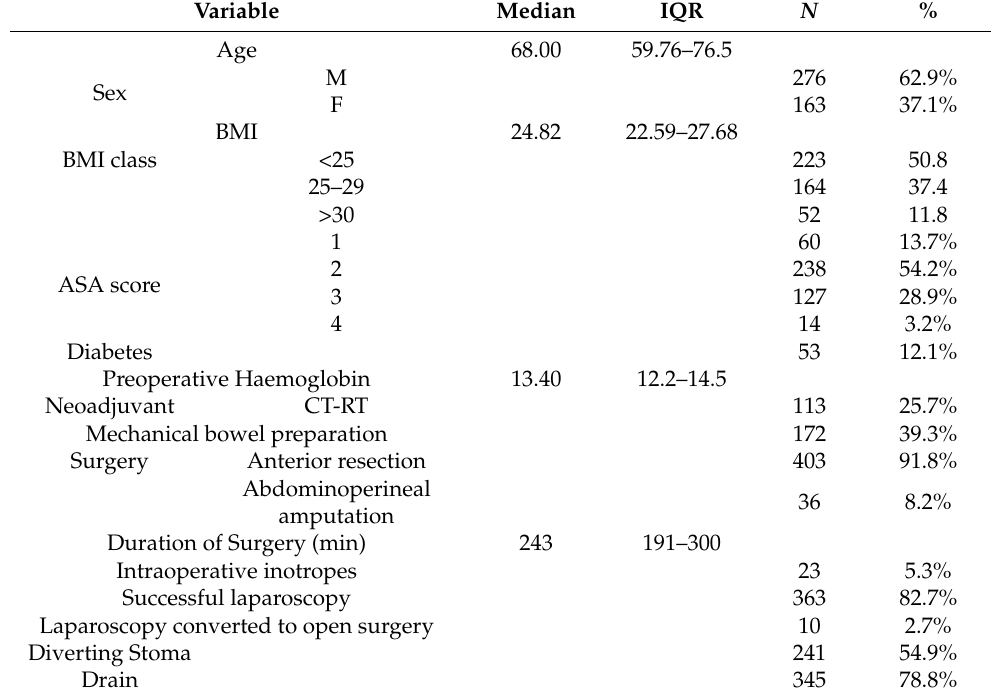
Table 1. Patients’ characteristics.